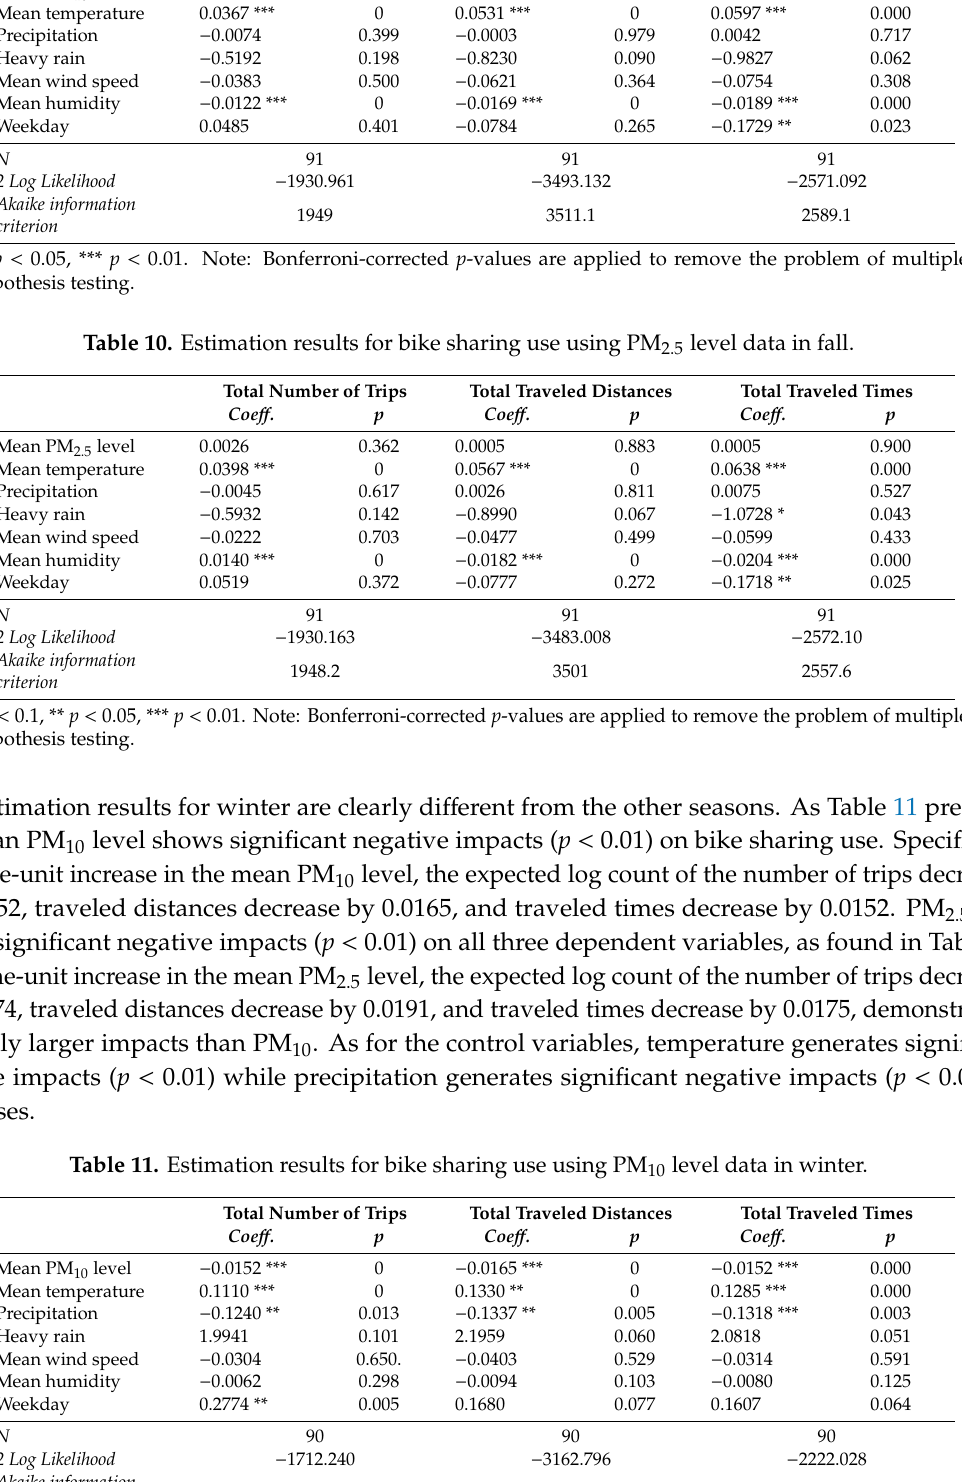
Total Traveled Times